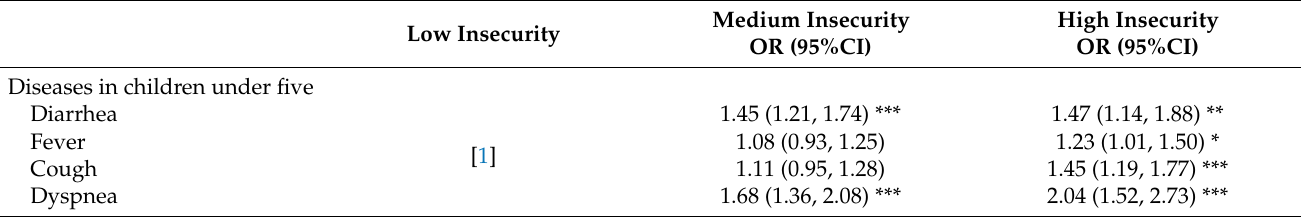
Table 5. Associations between self-reported insecurity with diseases in children under five